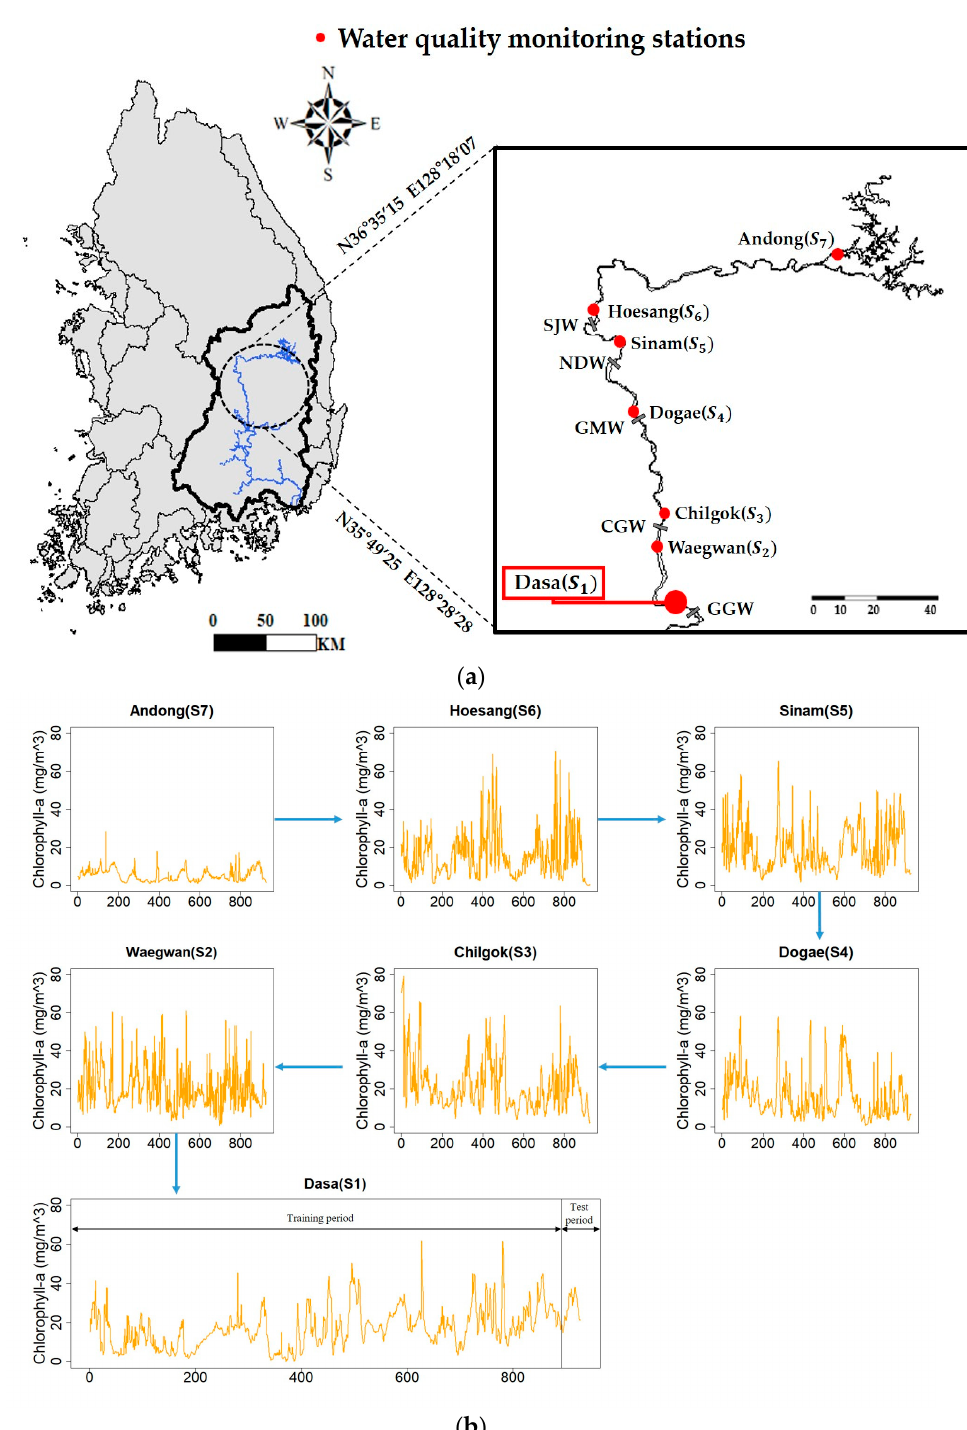
Figure 1. ( a ) Monitoring sites along the Nakdong River. Data from Dasa weir and the weirs upstream of Dasa weir (totaling seven weirs) are used for the analysis in this study. ( b ) Concentration of chlorophyll- a at each monitoring site. The blue arrow represents the direction of the river flow.